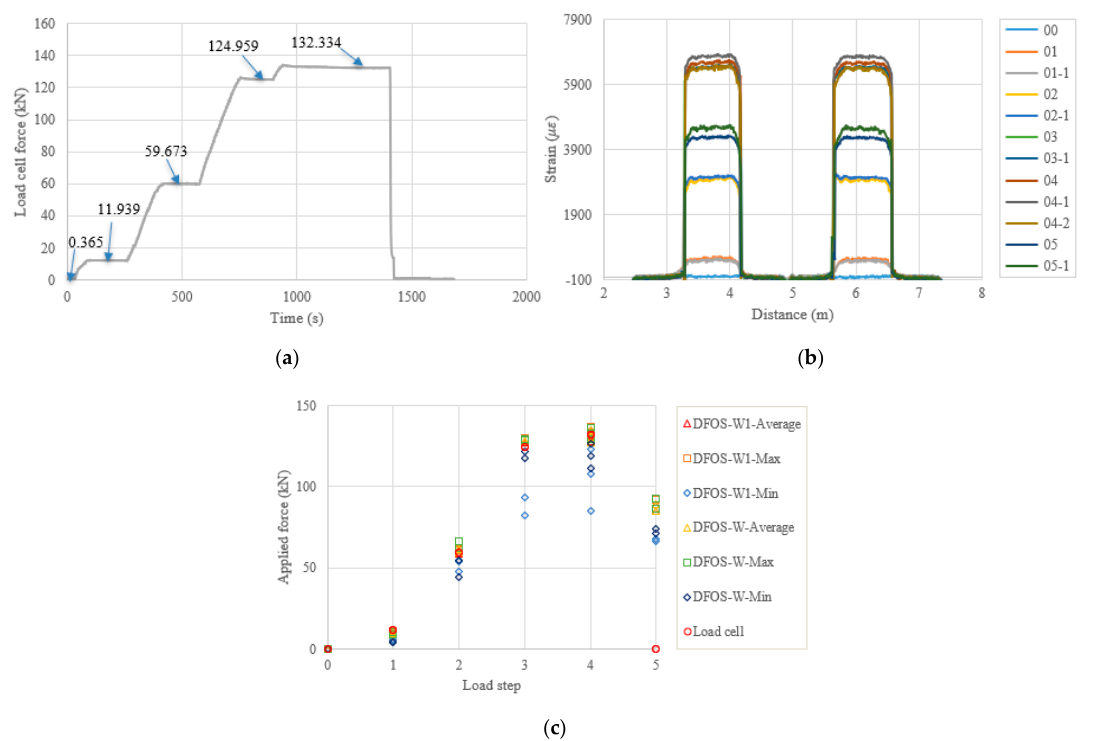
Figure 11. ( a ) Load cell readings for PC3-1; ( b ) strain distribution along the strand (W1 and W fibers) (In the legend, the first number represents the load step, and the second number represents measurement times at the load step); and ( c ) applied force changes at different load steps. Table 8. Prestressing force monitored by load cell and DFOSs for PC3-1 (unit: kN).